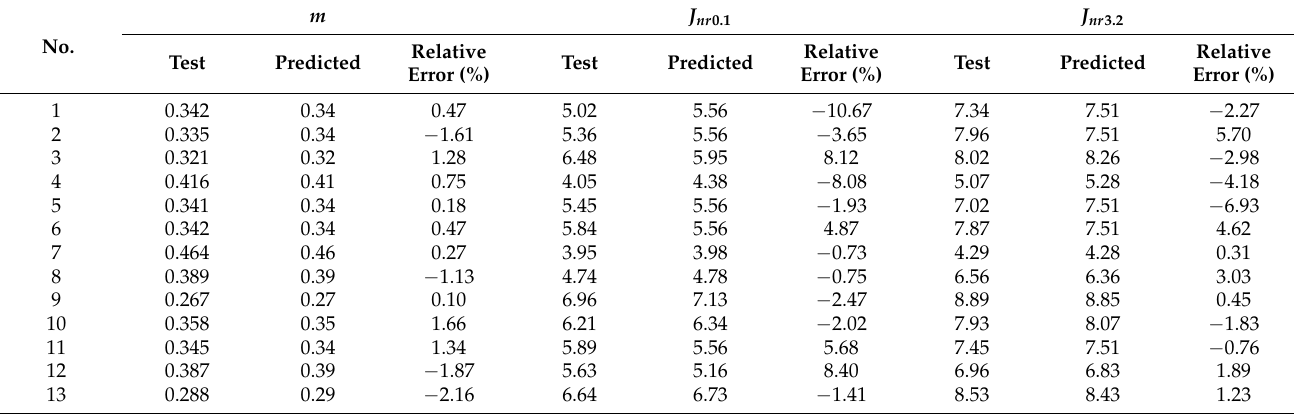
Table 7. Comparison of test results and model prediction results.